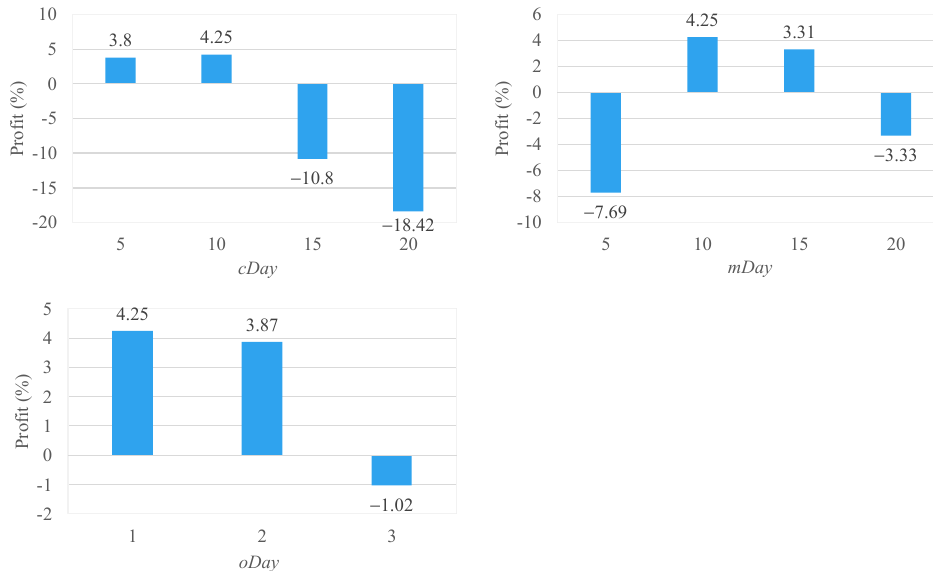
Figure 7. Profits from different parameter settings on four-year dataset (2009–2012).